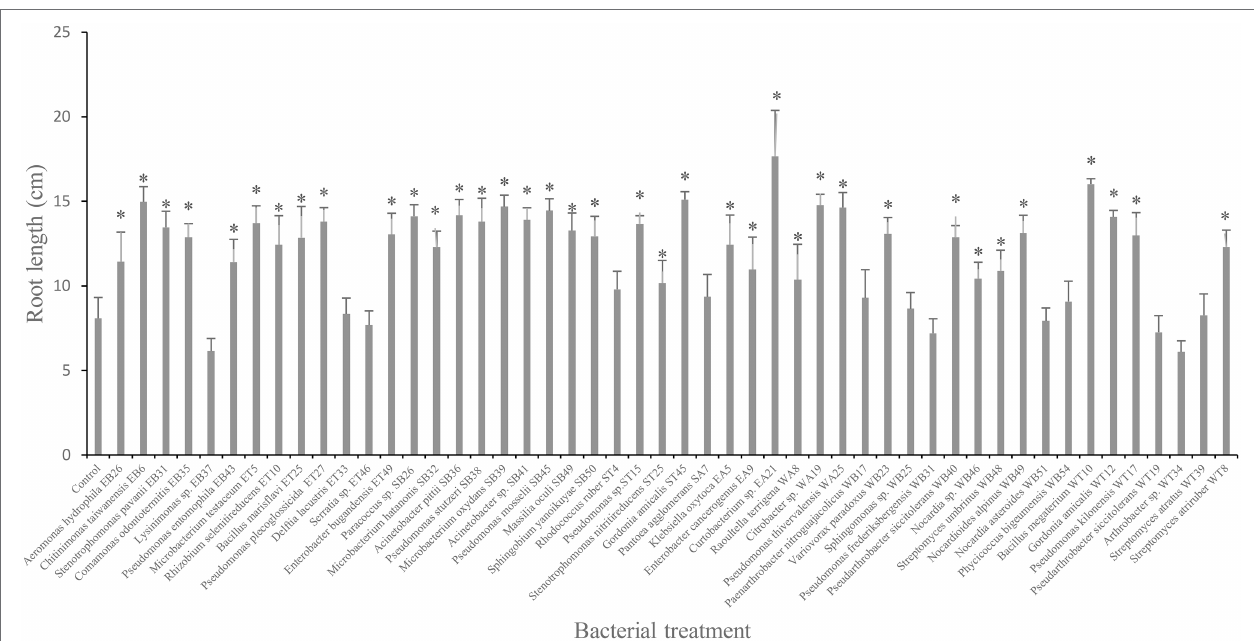
FIGURE 1 | Effect of selected plant growth-promoting rhizobacteria (PGPR) bacterial isolates on root length (cm) of canola plants measured after 7 days of growth. Error bars represent SDs and * indicates a significant difference compared to the control according to a Dunnett test, p ≤ 0.05.